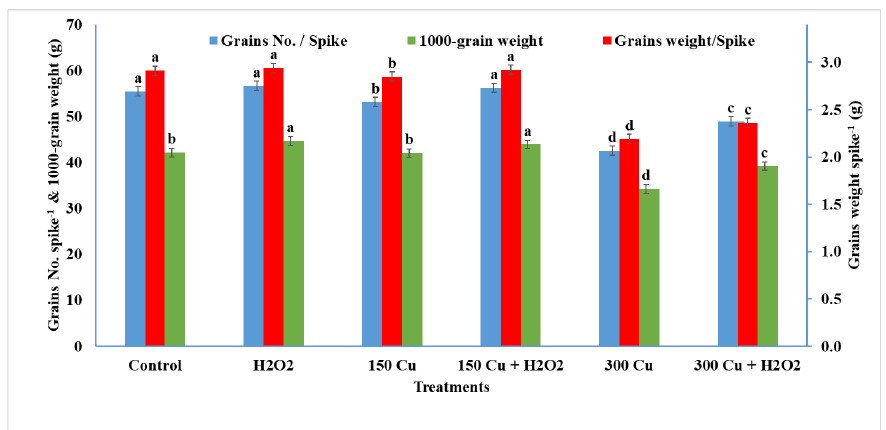
Figure 8. Effect of hydrogen peroxide on yield traits of wheat grown in contaminated sandy soil. Means followed by the same letter in each parameter are not significantly different according to the least significant differences (LSD) test ( p ≤ 0.05). Error bars are ± Standard Error (SE). 2.8. Effects of Hydrogen Peroxide on Cu, Zn, and Cd Concentration of Whole Wheat Plants Grown under Cu Stress Stressed wheat plants with 300 mg Cu kg −1 soil significantly contained the highest Cu (18 mg kg −1 DM) and Cd (0.70 mg kg −1 DM) followed by stressed plants with 150 mg Cu kg −1 soil in comparison to unstressed plants (control; 15 mg Cu kg −1 DM and 0.50 mg Cd kg −1 DM) or plants treated with H 2 O 2 (12 mg kg −1 DM and 0.39 mg Cd kg −1 DM) (Figure 9). However, plants treated only with H 2 O 2 contained the highest Zn (16.6 mg kg −1 DM), followed by plants treated with mg Cu kg −1 soil + H 2 O 2 (16.2 mg kg −1 DM) and untreated plants (15.5 mg kg −1 DM) compared to plants treated with 300 mg Cu kg −1 soil (14.6 mg Zn kg −1 DM). Figure 9. Effect of hydrogen peroxide on elemental analysis of whole wheat plants grown in con- taminated sandy soil. Means followed by the same letter in each parameter are not significantly different according to the least significant differences (LSD) test ( p ≤ 0.05). Error bars are ± Standard Error (SE).